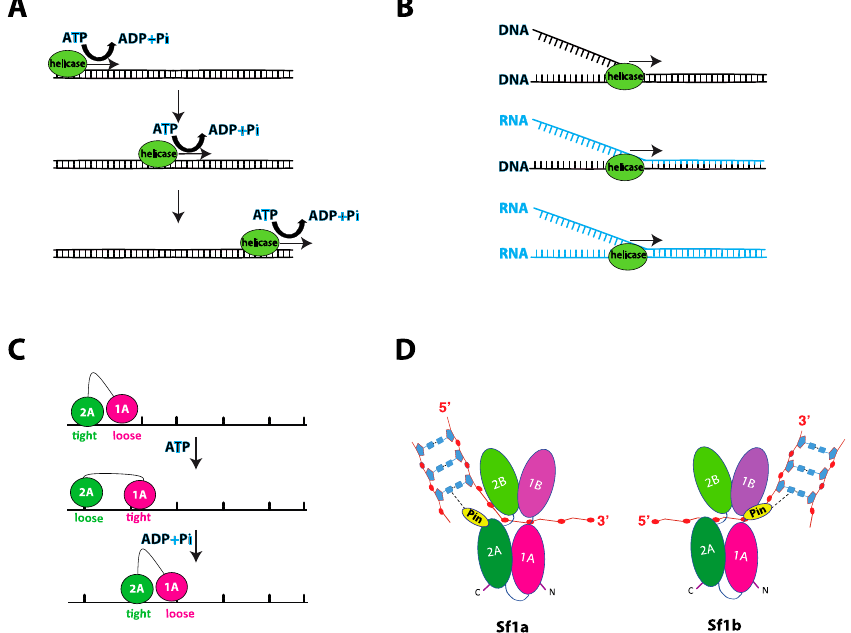
Figure 2. Multiple faces of helicases activity. ( A ) Schematic of helicase motion showing movement in a specific direction on nucleic acids coupled to ATP hydrolysis. ( B ) Schematics of nucleic acid duplex unwinding, specifically DNA-DNA, DNA-RNA, and RNA-RNA, by helicases. DNA strands are colored black while RNA stands are colored light blue. ( C ) Illustration of the inchworm mechanism. Tandem RecA-like domains (magenta and green circles) make up the motor domain of the helicase. The motor domain interacts with the ssDNA track through DNA-binding domains, which alternate between tightly and loosely bound states. ATP binding is coupled to rotation of the RecA-like domains and changes in the ssDNA affinity of the DNA-binding domains, thus moving the helicase in a specific direction. ( D ) Illustration of the four subdomains in Sf1a and Sf1b, highlighting the presence of the wedge/pin domain located in the 2A subdomain for Sf1a and 1A subdomain for Sf1b. The wedge/pin domain interacts with the nucleic acid at the ds-ssDNA junction, aiding in the unwinding of the